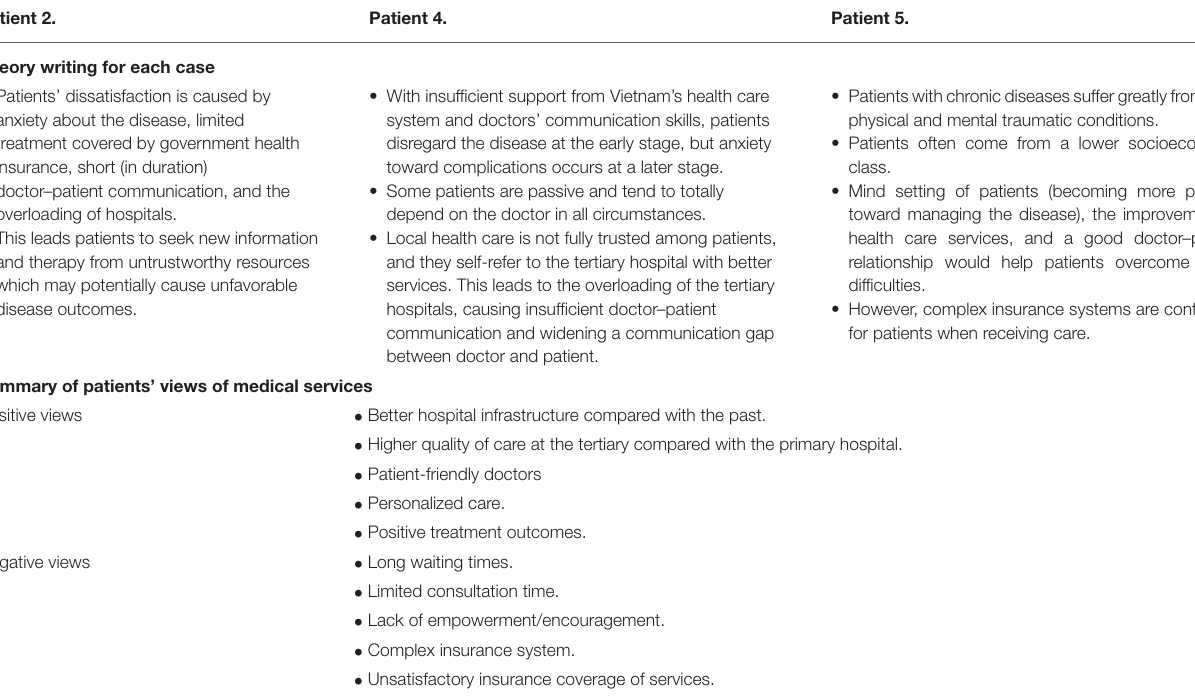
TABLE 2 | Results from SCAT analysis. Patient 2. Patient 4. Patient